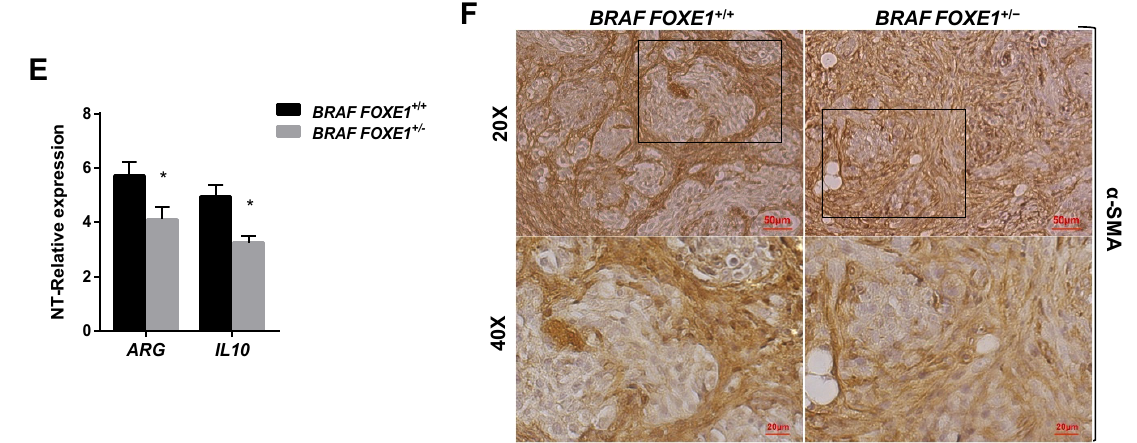
Figure 4. FOXE1 modulates macrophage recruitment in vivo. ( A ) BRAF FOXE1 +/+ and BRAF FOXE1 +/- mice were treated with doxycycline for one week to induce BRAF V600E -dependent thyroid cancer. RNA was isolated from pools of thyroids with the same genotype and treatment. Macrophage-related genes and ( B ) CCR2 and CSF1R expression was analysed by quantitative RT-PCR, and the results are reported as the fold change of BRAF FOXE1 +/+ - and BRAF FOXE1 +/- -treated groups on the respective untreated group. * p < 0.05, ** p < 0.01; *** p < 0.001. ( C ) Thyroid sections were analysed by immunohistochemical staining for macrophage markers IBA1 and ( D ) GALECTIN3. Nuclei are stained with haematoxylin. 20 × (upper panels) and 40 × (lower panels) of the 20 × boxed area, magnifications are shown. ( E ) Expression analysis of M2 macrophage subpopulation markers ARGINASE1 (ARG) and INTERLEUKINE10 (IL10) on the same samples as in A. * p < 0.05. ( F ) Immunohistochemical analysis of α -SMA in thyroid sections from BRAF FOXE1 +/+ and BRAF FOXE1 +/- doxycycline-treated mice. Nuclei are stained with haematoxylin. 20X (upper panel) and 40X (lower panels) of the area boxed in 20 × magnifications are shown. The images are representative of six different images.